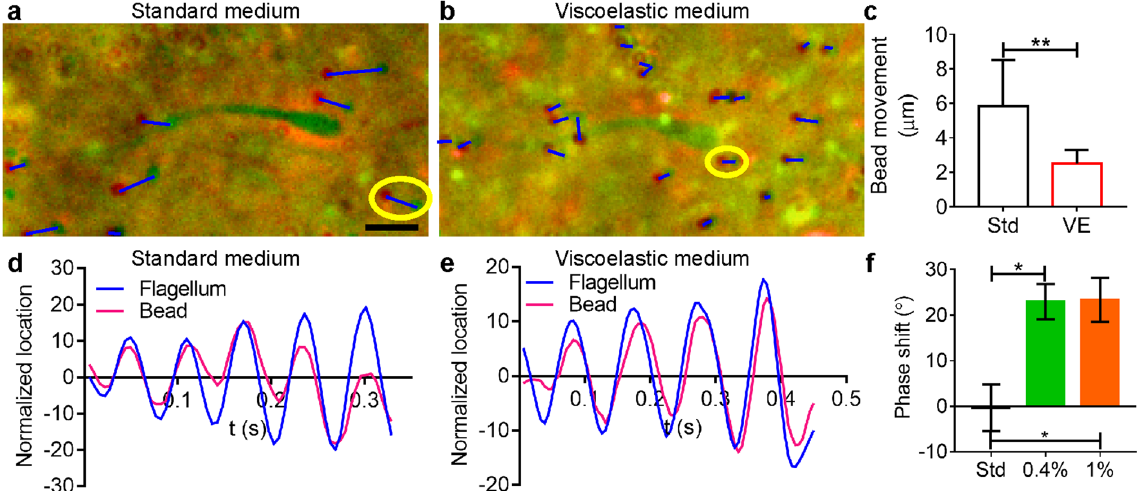
Figure 3. Role of elastic coupling revealed by bead tracking. ( a , b ) Bead displacements caused by nearby swimmers, shown by superposition of two consecutive images, the first coloured red and the second coloured green. ( a ) Images of sperm and beads in standard medium had been taken 0.54 sec apart (initial: red, final: green, scale bar: 10 µ m). ( b ) Images of sperm and beads in viscoelastic medium (0.7% LC-PAM) had been taken 1.51 s apart. Blue lines were added to show the distance moved by each bead. Yellow circles in ( a ) and ( b ) denote the beads used for phase tracking in ( d ) and ( e ). ( c ) Bead movements are significantly lower in viscoelastic medium than in standard medium (p = 0.0013, Mann-Whitney test, N = 8,20), indicating that sperm generate a smaller flow field in viscoelastic medium. ( d , e ) Oscillation of a sperm flagellum and that of the nearest bead. The flagellum oscillation is reported as the location of the point on the flagellum that is directly above the bead. In standard medium ( d ), the oscillation of bead and flagellum are synchronous. In viscoelastic medium ( e ), oscillation of the bead lags behind flagellar movement. ( f ) In standard medium, the average phase difference between the flagellum and the bead is close to 0, while in both viscoelastic media (0.4% and 1.0% LC-PAM) there is a 20° lag, indicating that elasticity plays a role in the mechanical coupling ( p = 0.02, 0.03, one-way ANOVA, N =